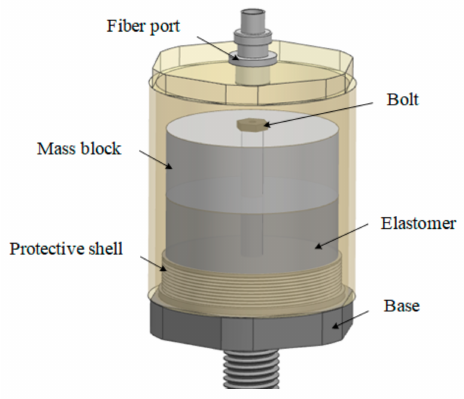
Figure 3. Basic sensor structure.